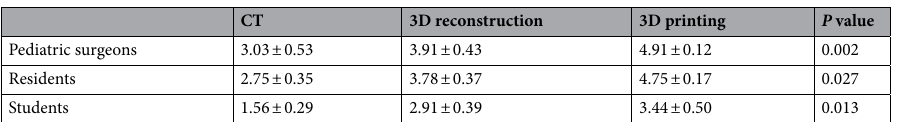
Table 5. Degree of preoperative comprehension by using CT, 3D reconstruction, and 3D printing model by certified pediatric surgeons, residents and students. Scale: 0 (poor) to 5 (excellent). CT, computed tomography.